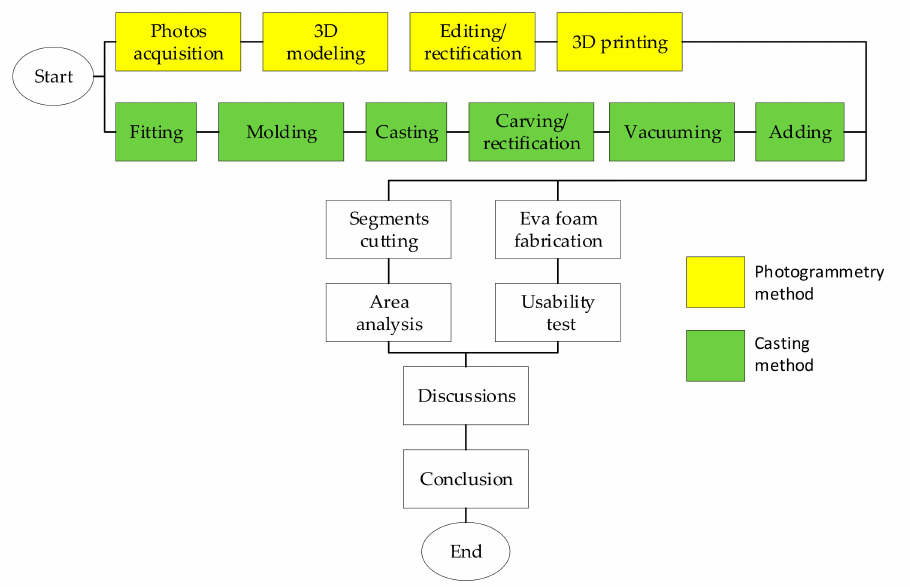
Figure 1. Schematic diagram of the proposed study.